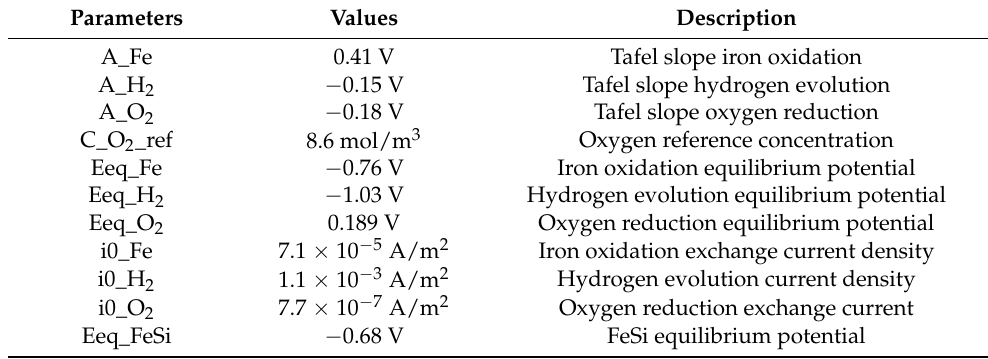
Table 4. Calculation